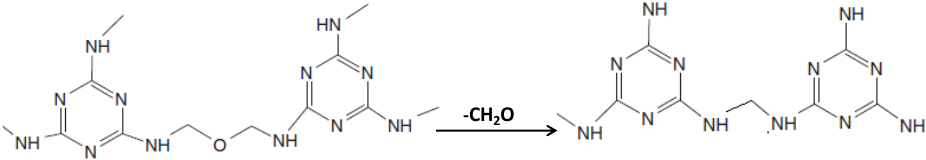
Table 5. Quantities of evolved gases calculated from TGA-FTIR spectra of UP, MF, and their blends in